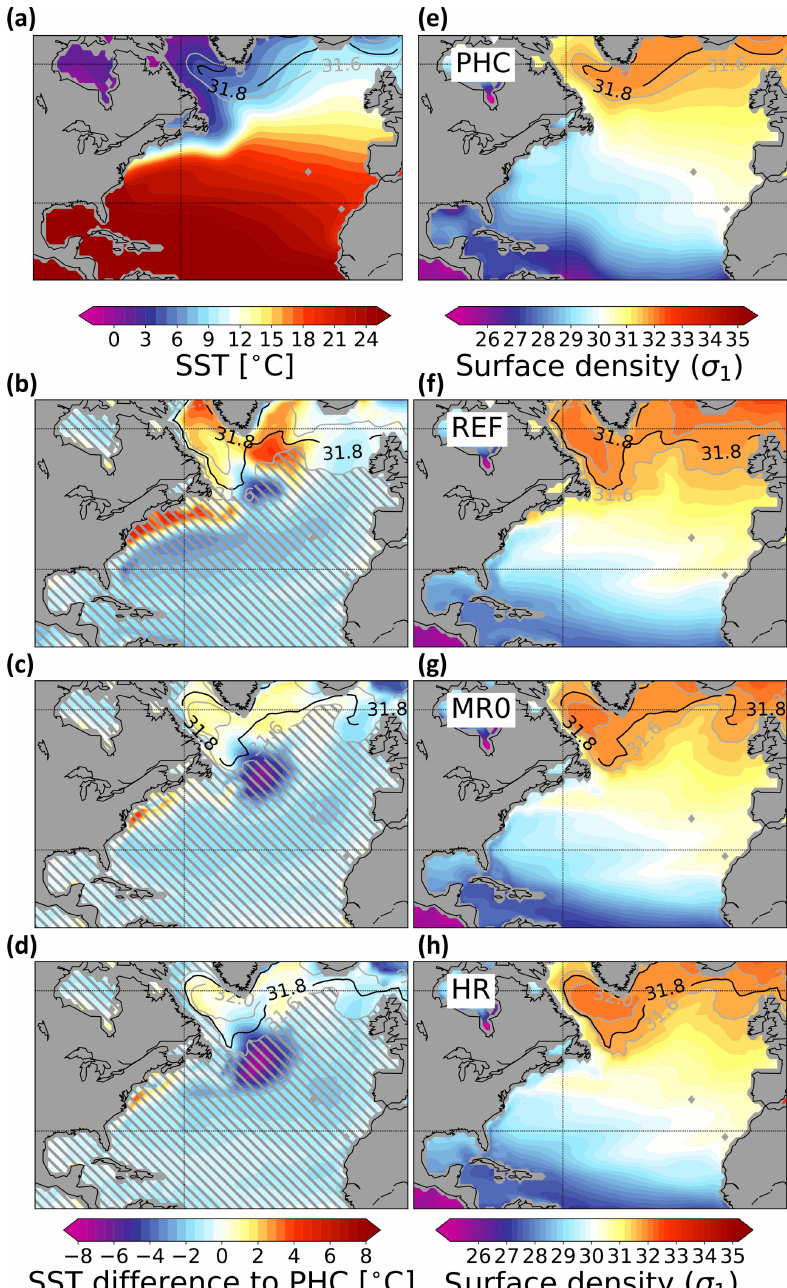
Figure 9. (a) The North Atlantic sea surface temperature and (e) σ 1 –density structure at the ocean surface, as determined from PHC (PHC 3.0, updated from Steele et al., 2001). Black and gray contours indicate outcropping areas for typical isopycnal surfaces found in the deep ocean around 1000m (e.g., σ 1 = 31 . 8). (f–h) Same for the simulated density structure in REF, MR0, and HR (years 71–100). (b–d) Sea surface temperature (SST) biases in the three simulations (years 71–100) with respect to PHC in panel (a) . Three simulated σ 1 –density contours that represent the “mapping” to deeper ocean layers are overlaid with black and gray contours (identical to the contour levels in panels (f) – (h) . To highlight the SST improvements in the areas encircled by these contours, hatching grays out regions that are not in contact with the deep ocean around 600–1000m (based on the 30-year annual